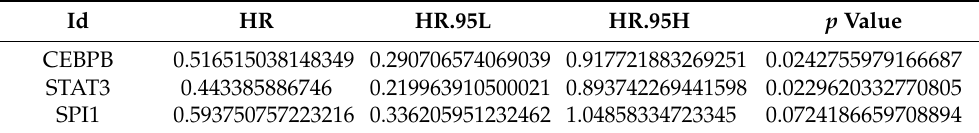
Table 2. Univariate Cox regression analysis of central genes.